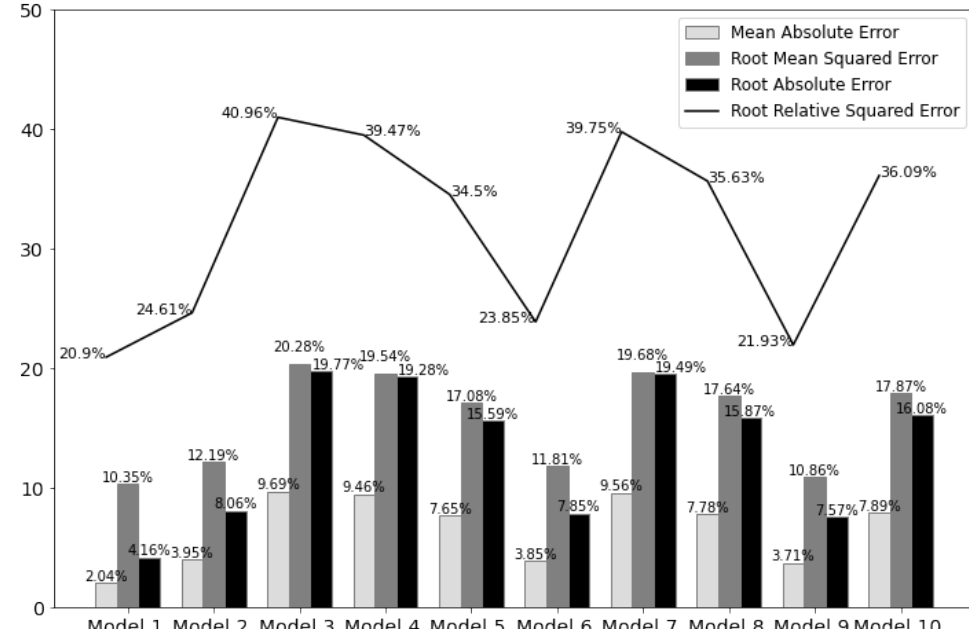
Figure 7. Errors associated with all the models.